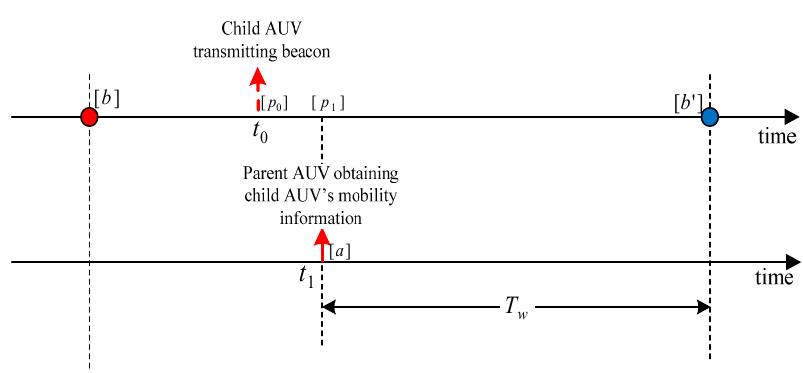
T (All the locations w